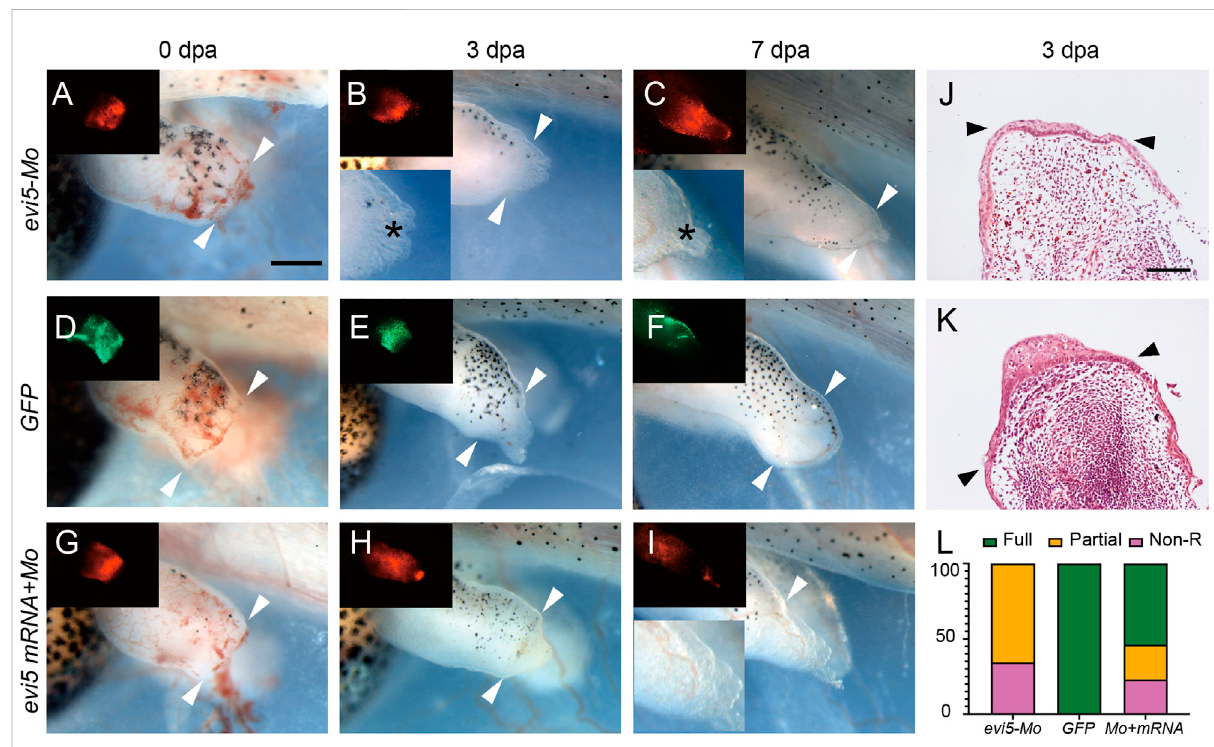
FIGURE 3 Xenopus tadpolelimbregenerationafterEvi5knockdown. (A – I) Stage52 – 53tadpolehindlimbsat0,3and7dpa,afterinjection/electroporation of evi5 Mo (A – C) , GFP DNA (D – F) , or evi5 mRNA + evi5 Mo (G – I) . Fluorescent images (insets) indicate site of injected materials. Bright fi eld insets show enlarged views of the limb stump. Black * indicates the epithelium layer formed in evi5 Mo-injected tadpole limbs. White arrowheads indicate amputation levels. Scale bar: 0.5 mm. (J , K) HE staining of the evi5 Mo and GFP-injected 3 dpa limb regenerates, showing that blastema formation was defective in evi5 Mo-injected tadpole limb. Scale bar represents 0.2 mm. (L) Stacking graph of non-regenerative, partial regenerative and full regenerative tadpole limbs.